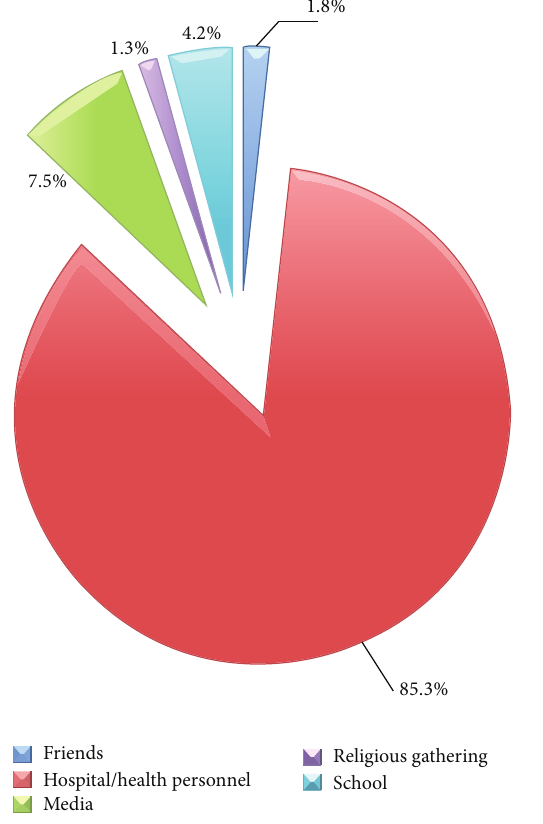
Figure 3: Source of information of participants regarding